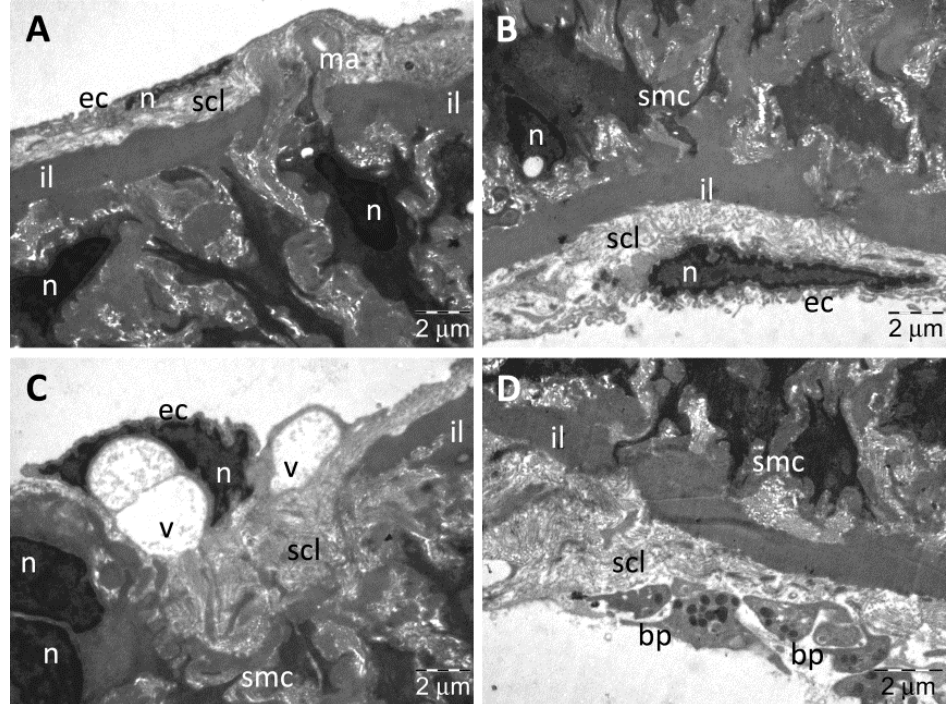
Figure 9. TEM investigation of the descending aorta in rats with HFD for 9 months; the last month with experimental-induced diabetes mellitus and subcutaneous administration of insulin showed altered ultrastructure: thinned intima ( A , C ), with large vacuoles ( C ) and endothelial cells removed from the subendothelial layer ( D ), and a subendothelial connective layer with a heterogeneous structure ( A – D ); smooth muscle cells with cytoplasmic vacuolations ( A , B ), and heterogeneous extracellular matrix with rarefied areas in media ( A – D ) (bp, blood platelets; ec, endothelial cell; il, inner elastic lamina; g, glycogen; m, mitochondria; ma, macrophage; n, nucleus; scl, subendothelial connective layer; smc, smooth muscle cell; v, vacuole).